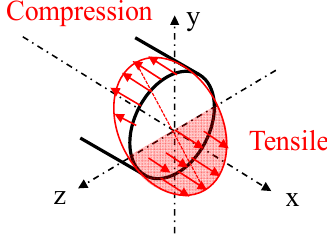
Figure 4. Representation of a bending stress.